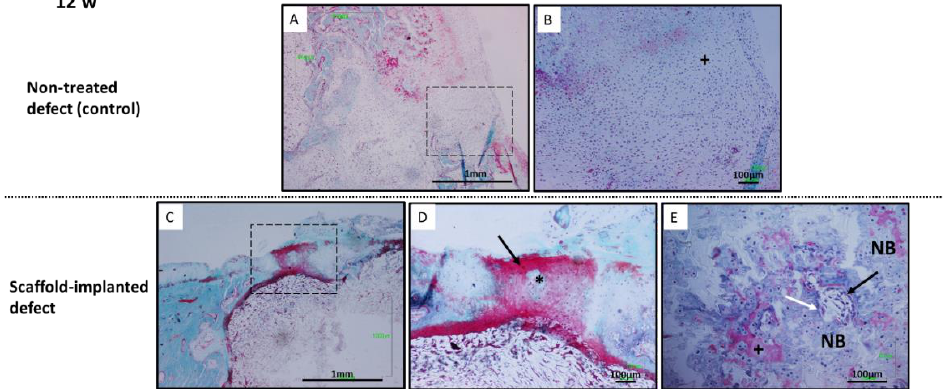
Figure 11. Histological evaluation at 12 weeks post-operation. Non-treated defects ( A – B ): the defect cavity was filled by fibrous tissue formation. Fibroblasts cells (+). Biomimetic scaffolds ( C – E ): ( C – D ) regenerated cartilage was more cellular and with more extracellular matrix compared to adjacent normal cartilage tissue. Chondrocyte-like cells (*). ( D ) Reparative tissue exhibited cartilage-like extracellular collagen matrix deposition (red staining) (arrow). ( E ) Neoformed remodelled bone was developed at subchondral space (NB). Osteoblasts (black arrow), osteoclasts (white arrow), osteoid (+). Goldner trichrome